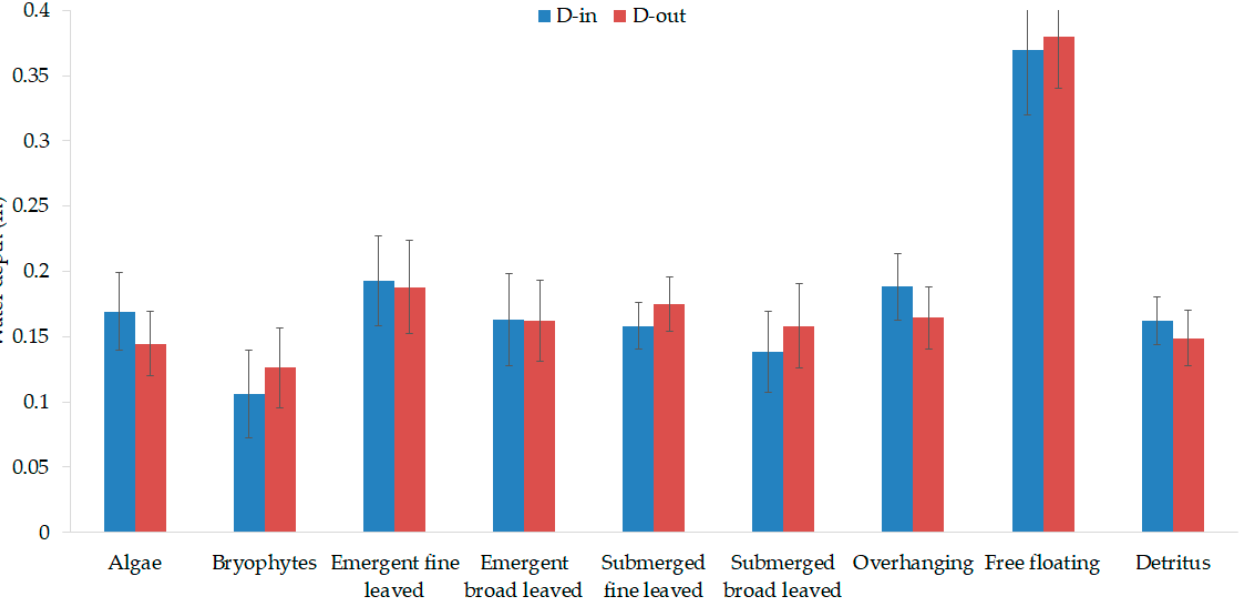
Figure 4. Average (±standard error) water depth before (D-in; m) and after (D-out; m) each vegetation type. Table 1. Manning’s roughness coefficients (n) for emergent and submerged vegetation types in varying densities. Numbers in parentheses indicate the number of samples of each vegetation type.